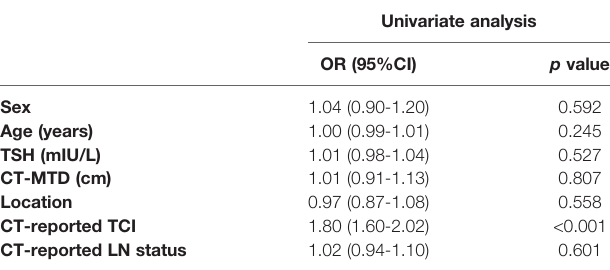
TABLE 2 | Univariate analysis of clinicoradiological characteristics in the training